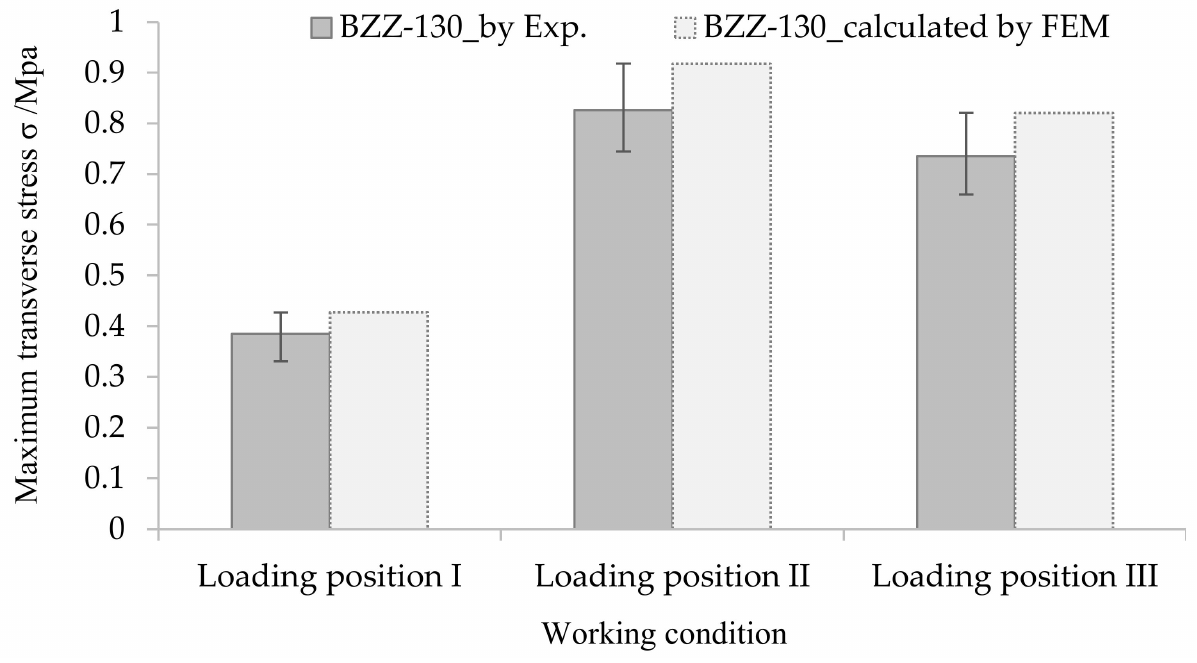
Figure 9. Comparison between the measured and simulated results of the transverse maximum tensile stress of asphalt pavement on the steel bridge deck under the action of BZZ-130 axle